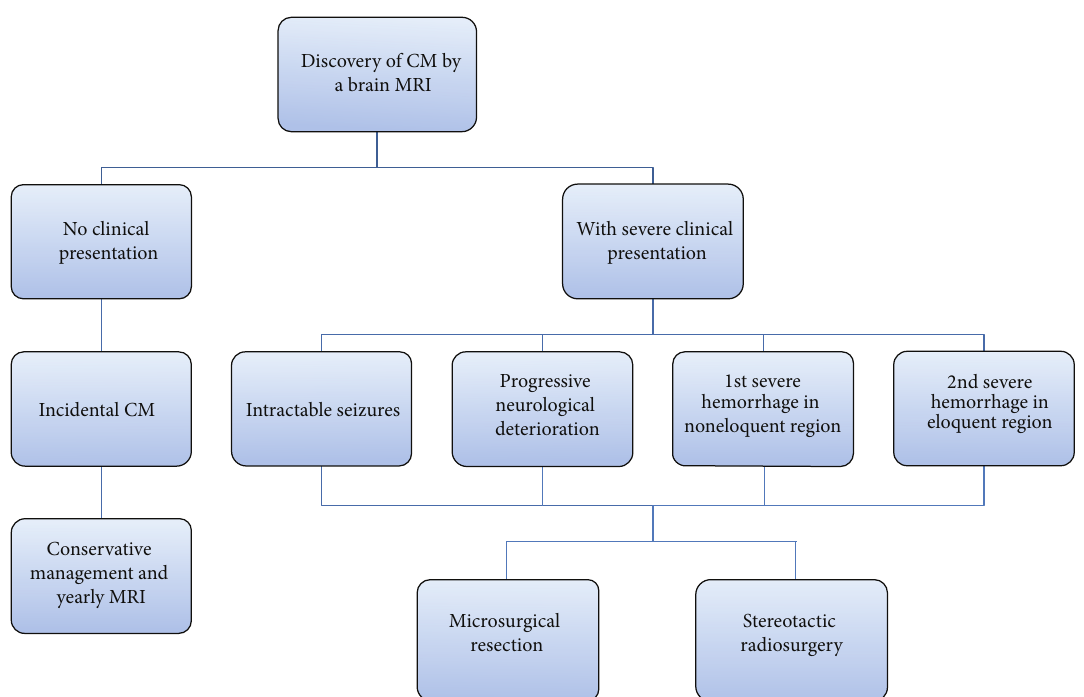
Figure 1: Flow-chart of the work-up and management of patients with cavernous malformations. Once a cavernomas is diagnosed via an MRI of the brain, deciding the course of treatment depends on the clinical presentation of the patient. Purely incidental cavernomas are managed conservatively and followed by yearly MRI scans. Cavernomas are treated by microsurgical resection or stereotactic radiosurgery if the patient is experiencing severe symptoms, such as intractable seizures, progressive neurological deterioration, one severe hemorrhage in a noneloquent region of the brain, or at least two severe hemorrhages in eloquent brain. Selecting between resection and radiosurgery depends on the location of the lesion and the severity of the presentation as explained in this